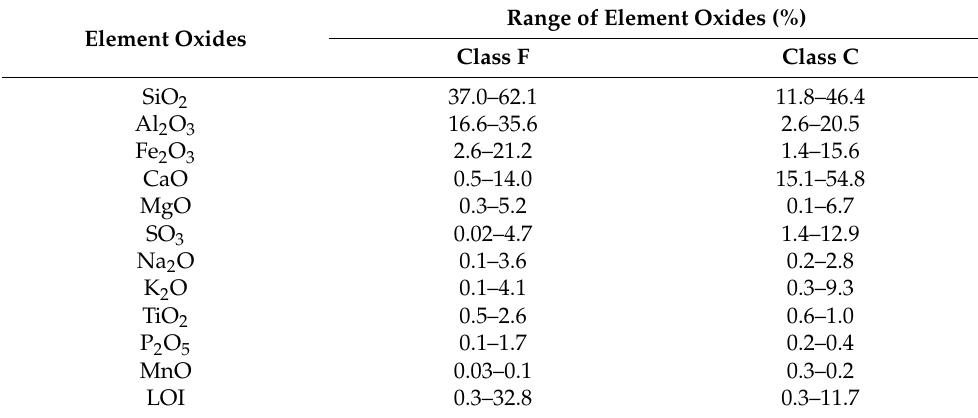
Table 1. Element oxides range in fly ash